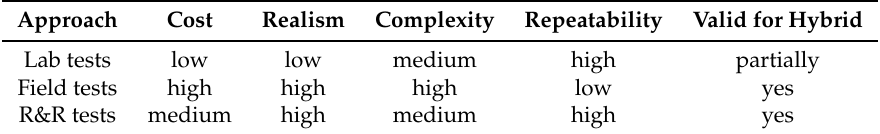
Table 1. Advantages and drawbacks of the approaches for GBPT testing. R&R: record and replay.